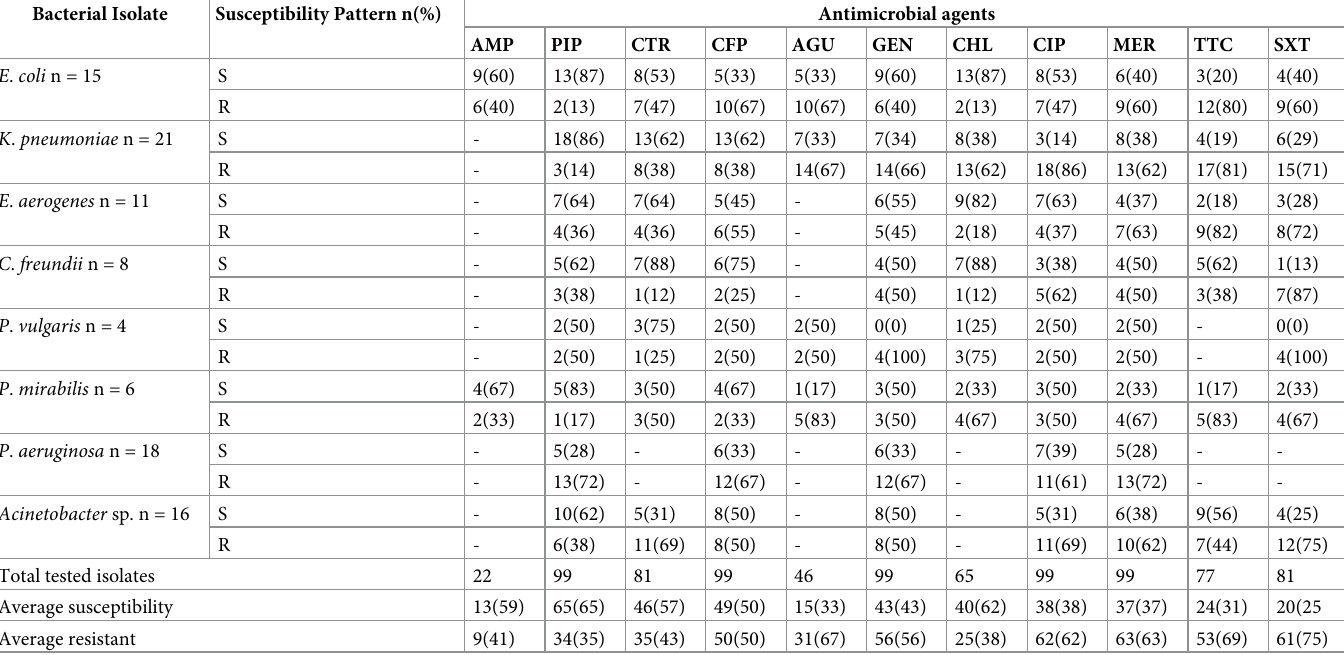
Table 5. Antibiotic susceptibility profiles of Gram-negative bacteria isolated from indoor air of selected wards of AMGH, February-April 2021. Bacterial Isolate Susceptibility Pattern